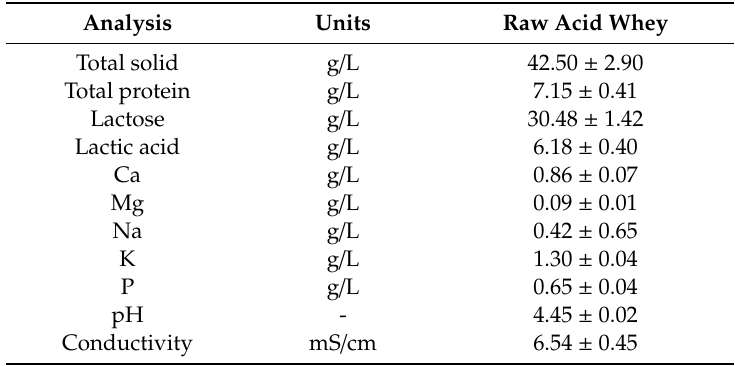
Table 1. Composition and physicochemical characteristics of raw acid whey.